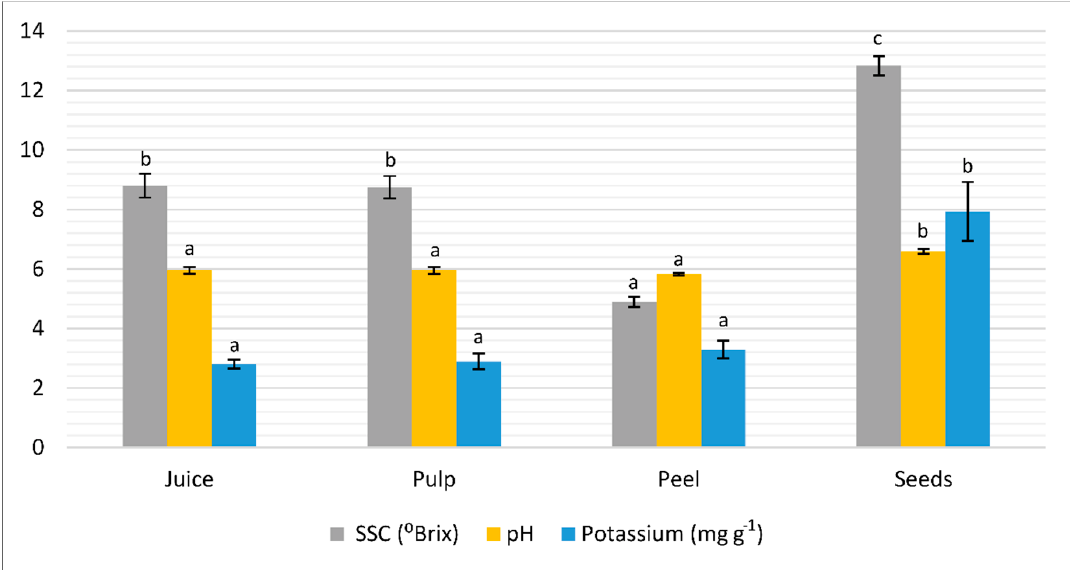
Figure 1. Soluble solids content, pH and potassium concentration of melon parts. Bars are 95% confidence intervals for the mean; for a specific characteristic, values with different letters are significantly different ( p < 0.05).